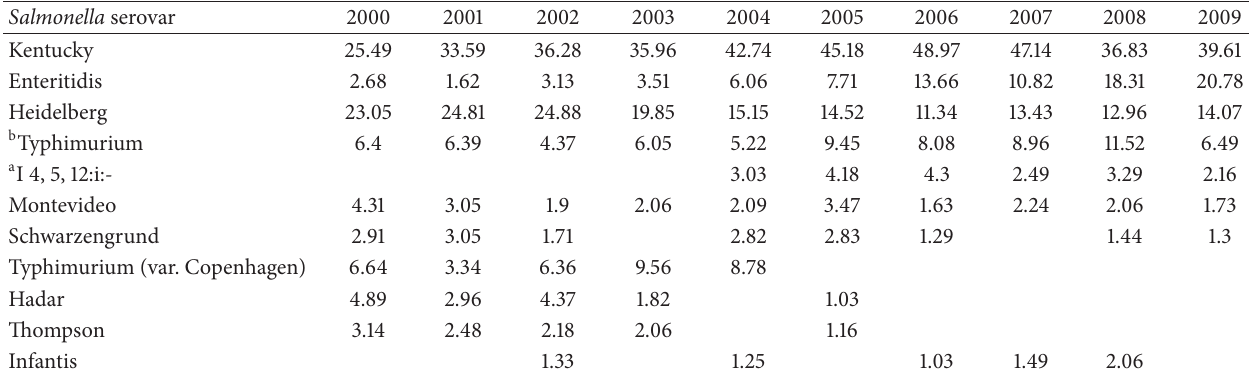
Table 5: Examples of Salmonella serovars (total % serotypes) profiles of Salmonella serovars isolated from broilers in the US [36]. Salmonella